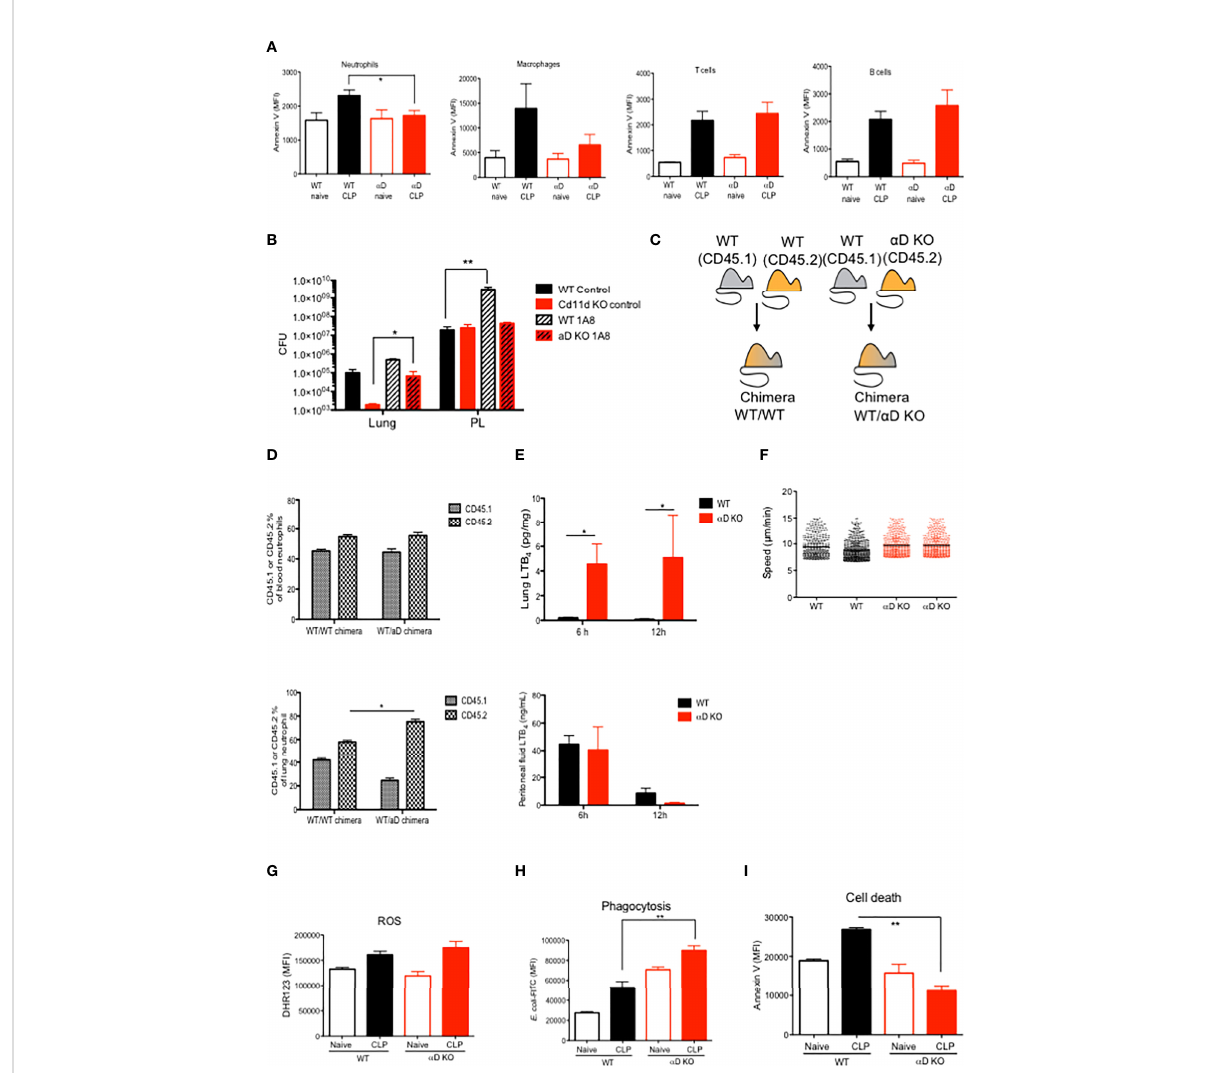
FIGURE 2 The functional of a D b 2 in neutrophils. (A) WT and a D KO lung leukocyte Annexin V expression at the baseline and at 12 hours after CLP. Data were shown as mean +/- S.D. of 4 mice. MFI; mean fl uorescence intensity. One-way ANOVA with Bonferroni post hoc analysis was performed. *p < 0.05. (B) Bacterial loads at the lungs and the peritoneal lavage in WT and a D KO mice with or without neutrophil depletion. Mice were subjected to CLP sepsis and the samples were obtained at 12 hours after CLP. Data were shown as mean +/- S.D. of 6 mice. One-way ANOVA with Bonferroni post hoc analysis was performed. *p < 0.05, **p < 0.01. (C) Chimera scheme. (D) Blood and lung neutrophil analysis of chimeric mice at 12 hours after CLP. Data were shown as mean +/- S.D. of 4 mice. One-way ANOVA with Bonferroni post hoc analysis was performed. *p < 0.05. (E) Lung and peritoneal cavity LTB 4 levels at 6 and 12 hours after CLP. Data were shown as mean +/- S.D. of 4 mice. One-way ANOVA with Bonferroni post hoc analysis was performed. *p < 0.05. (F) LTB 4 mediated bone marrow neutrophil chemotaxis assay. Each dot represents one neutrophil. One-way ANOVA with Bonferroni post hoc analysis was performed. No signi fi cance was observed. (G) Lung neutrophil ROS activity from naïve and post CLP mice. For CLP mice, lungs were obtained at 12 hours after CLP. Data were shown as mean +/- S.D. of 6 mice. One-way ANOVA with Bonferroni post hoc analysis was performed. No signi fi cance was observed. (H) Lung neutrophil phagocytosis activity from naïve and post CLP mice. For CLP mice, lungs were obtained at 12 hours after CLP. Data were shown as mean +/- S.D. of 6 mice. One-way ANOVA with Bonferroni post hoc analysis was performed. **p < 0.01. (I) Lung neutrophil Annexin V expression from naïve and post CLP mice. For CLP mice, lungs were obtained at 12 hours after CLP. Data were shown as mean +/- S.D. of 6 mice. One-way ANOVA with Bonferroni post hoc analysis was performed. **p <